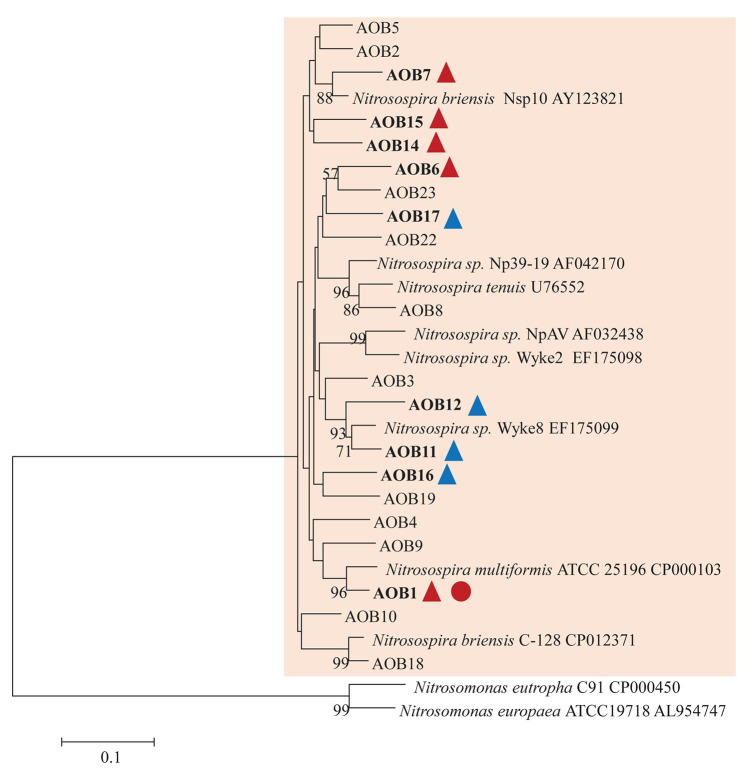
Neighbor joining tree for AOB partial amoA top 20 OTUs (covered 98.2% of total sequences). The scale bar represents 10% nucleic acid sequence divergence, and bootstrap values (>50%) are showed at branch points. OTUs are shown in bold if they were significantly changed by N treatment. Up triangles indicate a significant difference between values for control and AS treatments while circles indicate a significant difference between values for control and compost treatments. Red color indicates a significant higher abundance than control while blue color indicates a lower abundance.